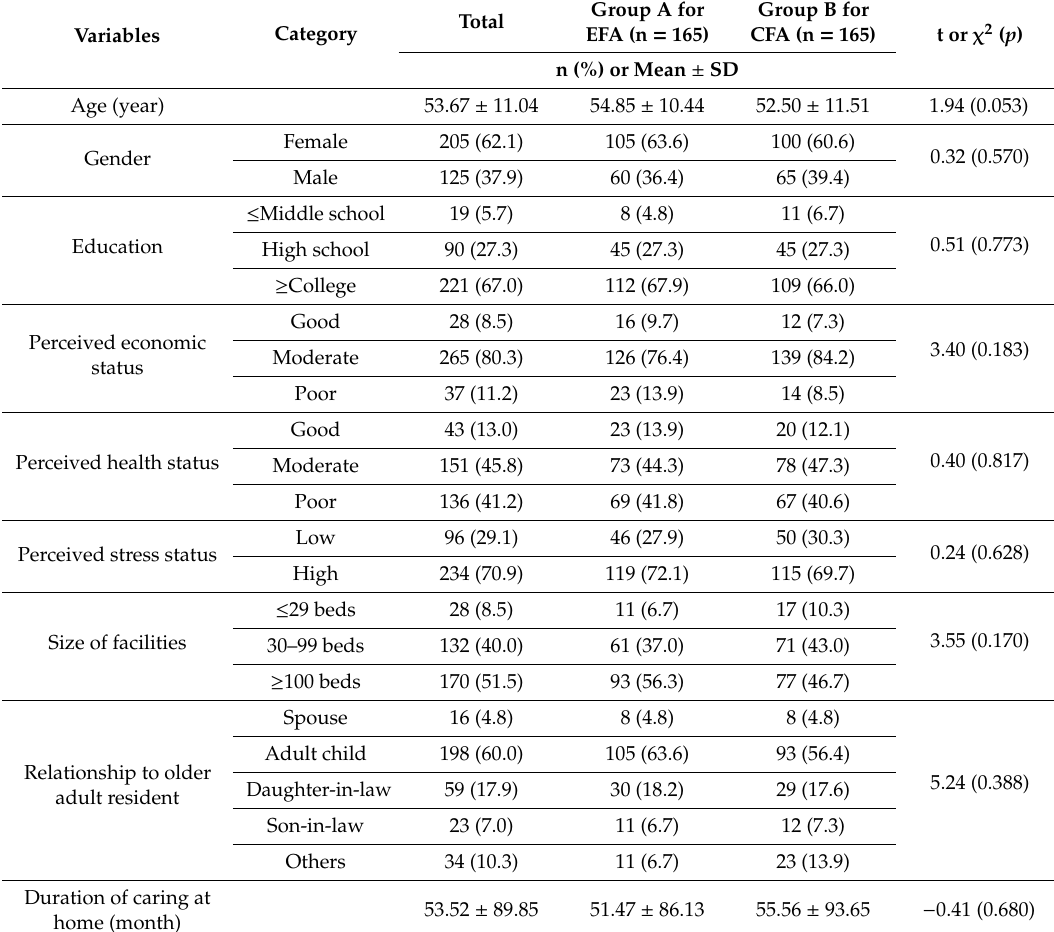
Table 1. General characteristics of participants. N =